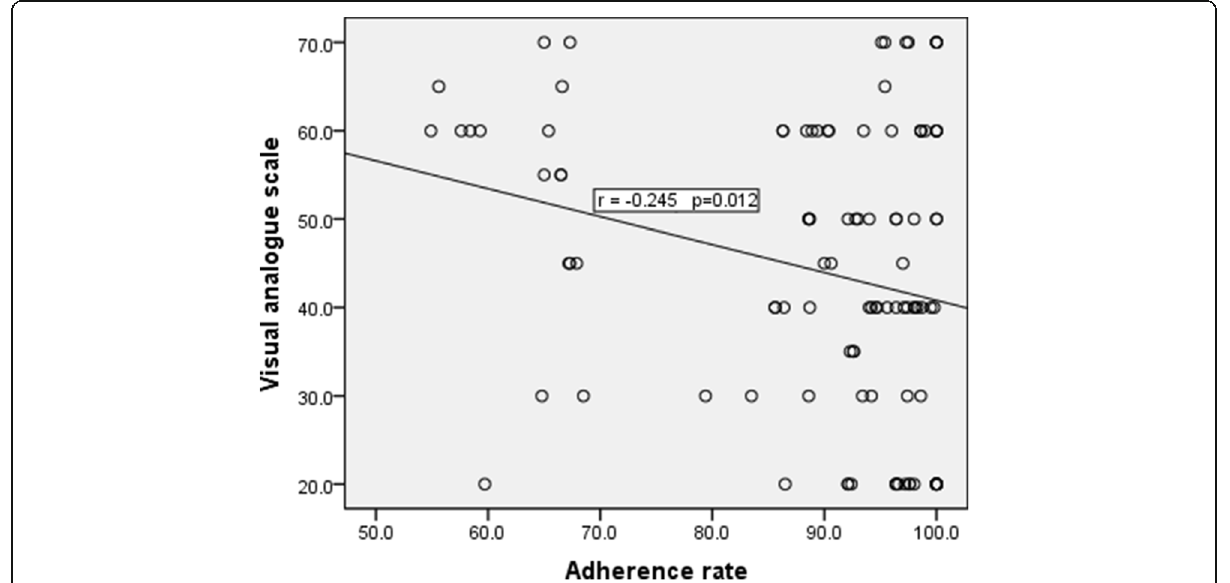
Fig. 3 Scatter diagram for correlation between adherence rate and visual analog scale of osteoarthritis patients after